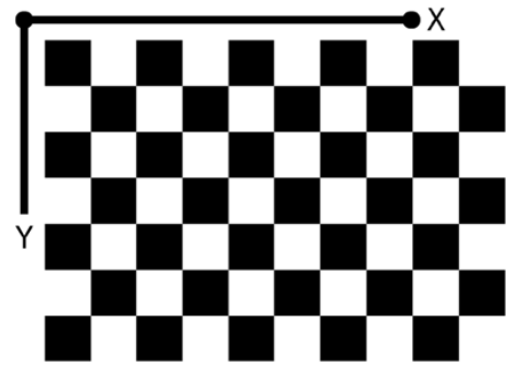
Figure 4. Example of the checkerboard image where the square size is 7-by-7.